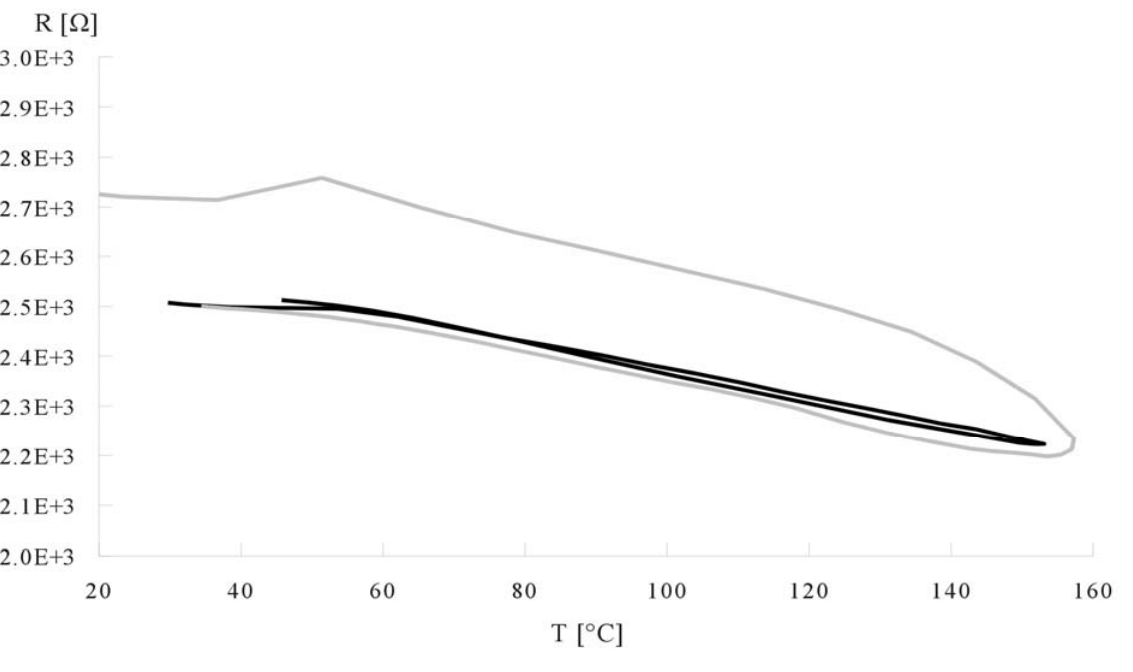
Figure 4. Resistance of stripes in function of temperature changes for 2% CNT samples after first (gray) and second (black) heating